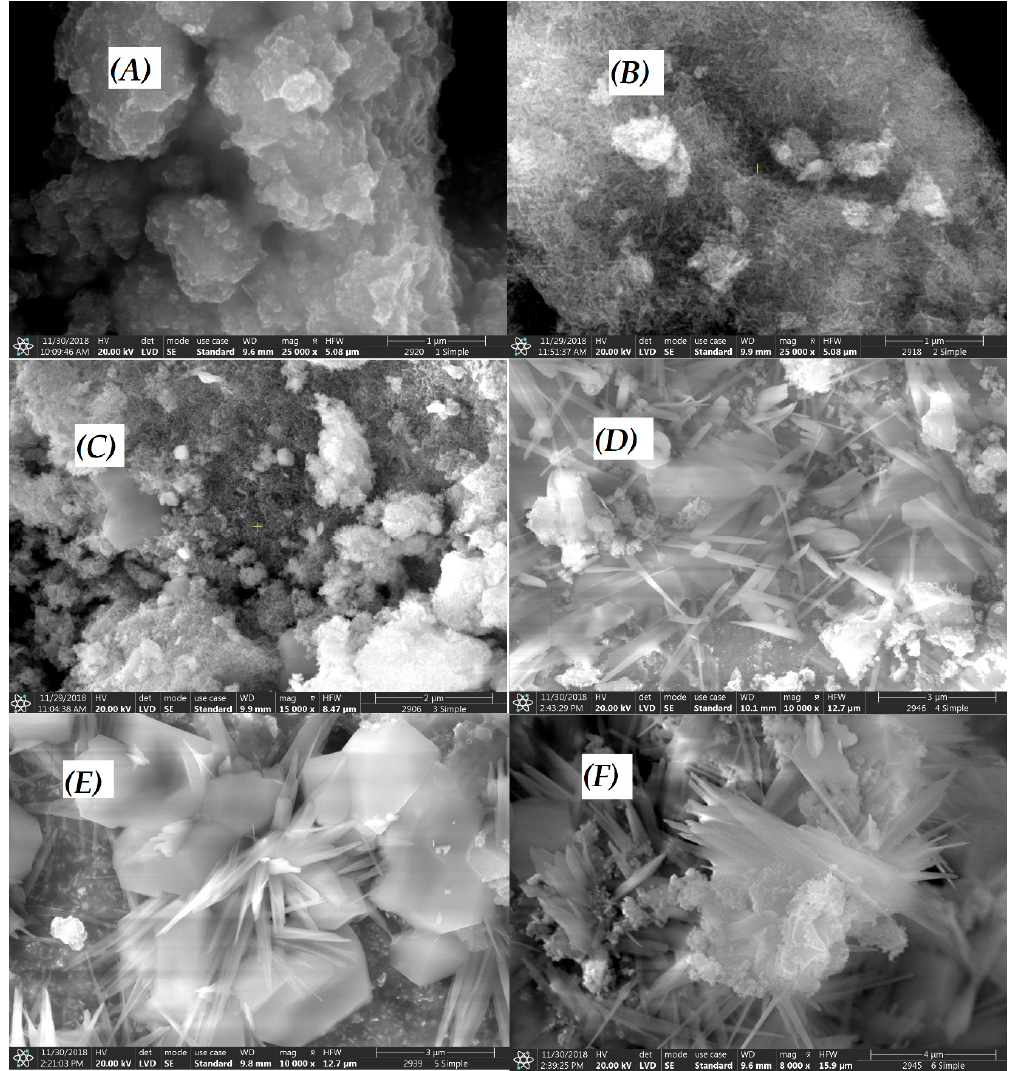
Figure 4. Scanning electron microscopy (SEM) images of Cu II(x) Fe II(1-x) Fe III2 O 4 : ( A ) x = 0 NP-1, ( B ) x = 0.2 NP-2, ( C ) x = 0.4 NP-3, ( D ) x = 0.6 NP-4, ( E ) x = 0.8 NP-5, ( F ) x = 1 NP-6 ferrites.